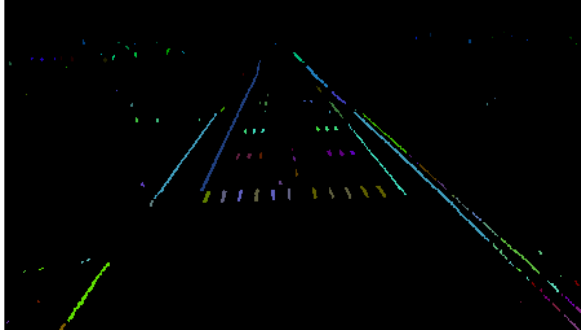
Figure 4. Label image that shows the separated pixel region image of binary image. The runway left edge marking is visible as a long inclined blue line left to the image